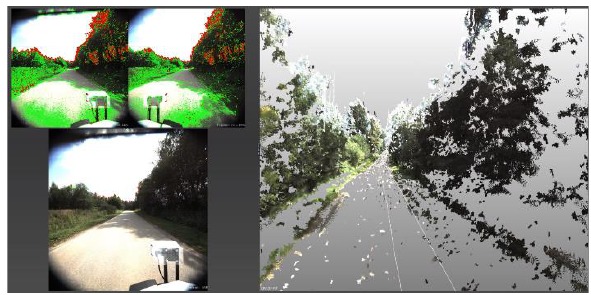
Figure 11. Spatial reconstruction process